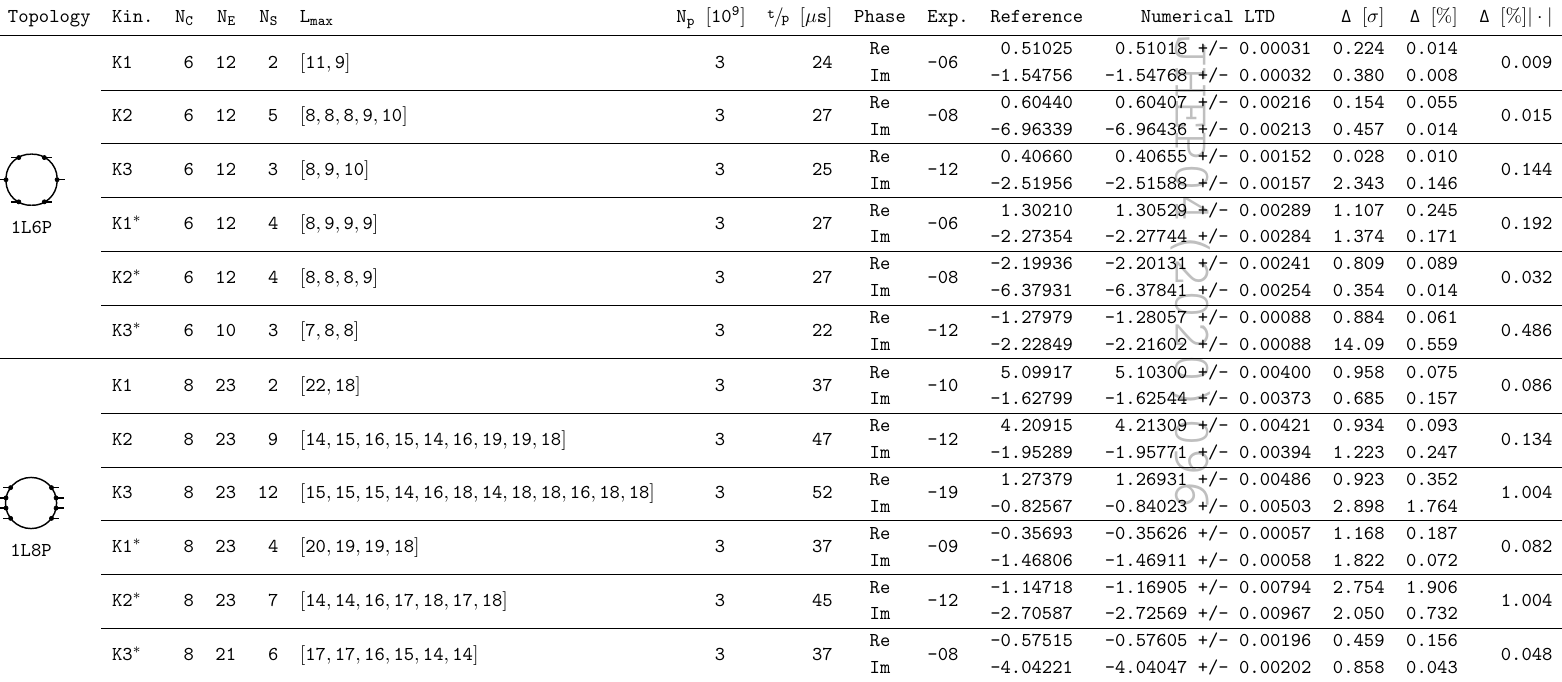
Table 5. Results for one-loop six-point and eight-point topologies for scattering kinematics (2 (indicated by a * ). See the main text for